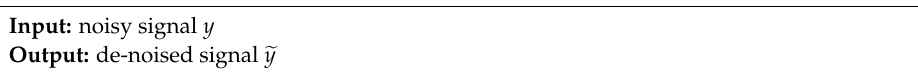
Algorithm 1. Procedure of the proposed method.